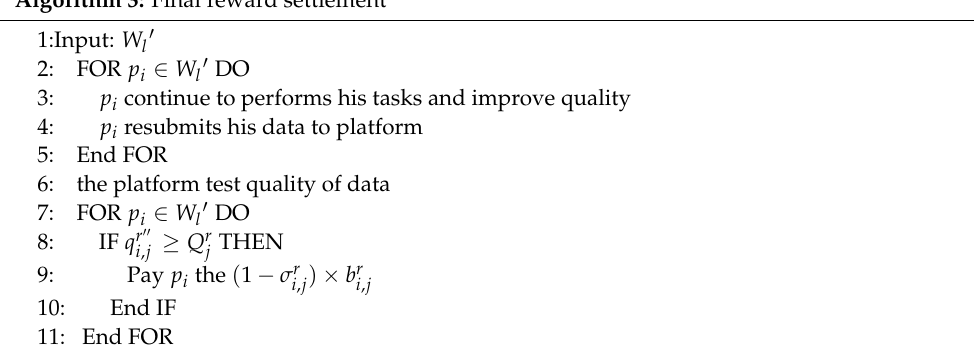
Algorithm 3: Final reward